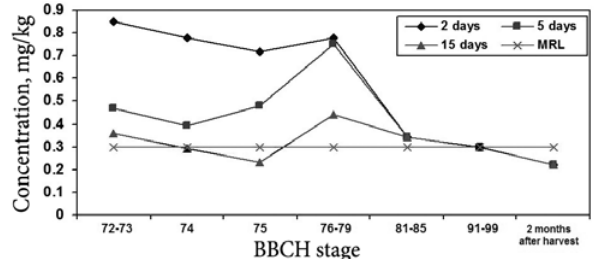
Fig. 11. Degradation of bifenthrin in Jonathan apples